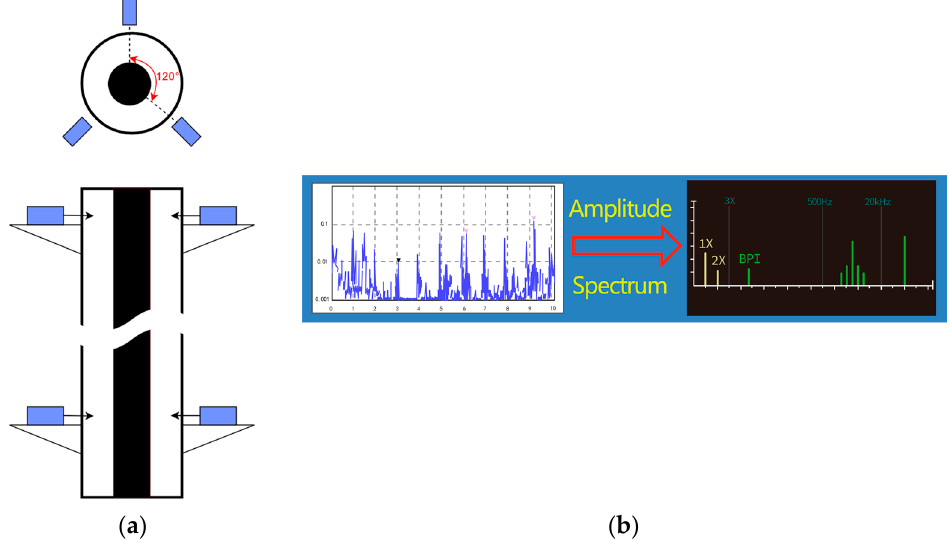
Figure 7. Design of experimental data collection system. ( a ) Schematic of the strain gauge; ( b ) multi-channel dynamic strain collector.